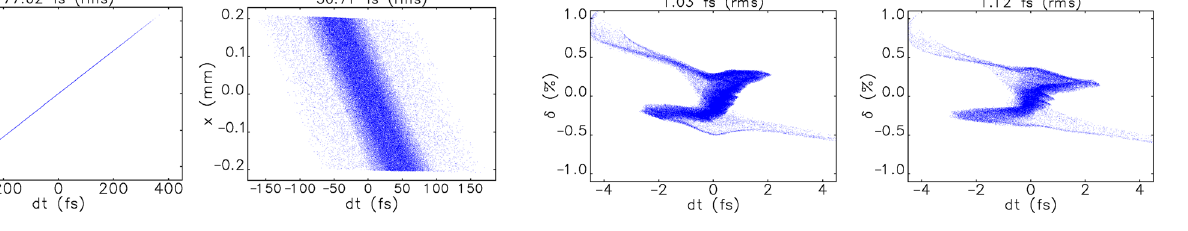
FIG. 11. Typical initial longitudinal phase space (left) and the bunch shape in the middle of the chicane (right) when only the central slice of the bunch was tracked.